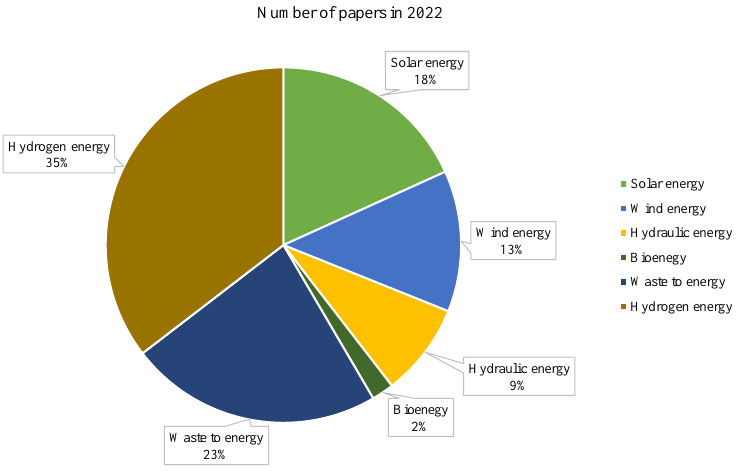
Figure 5. Number of published papers in the field of solar, wind, bio, hydraulic, waste, and hydrogen energy in 2022; accessed on 12 December 2022, 1.30 p.m.